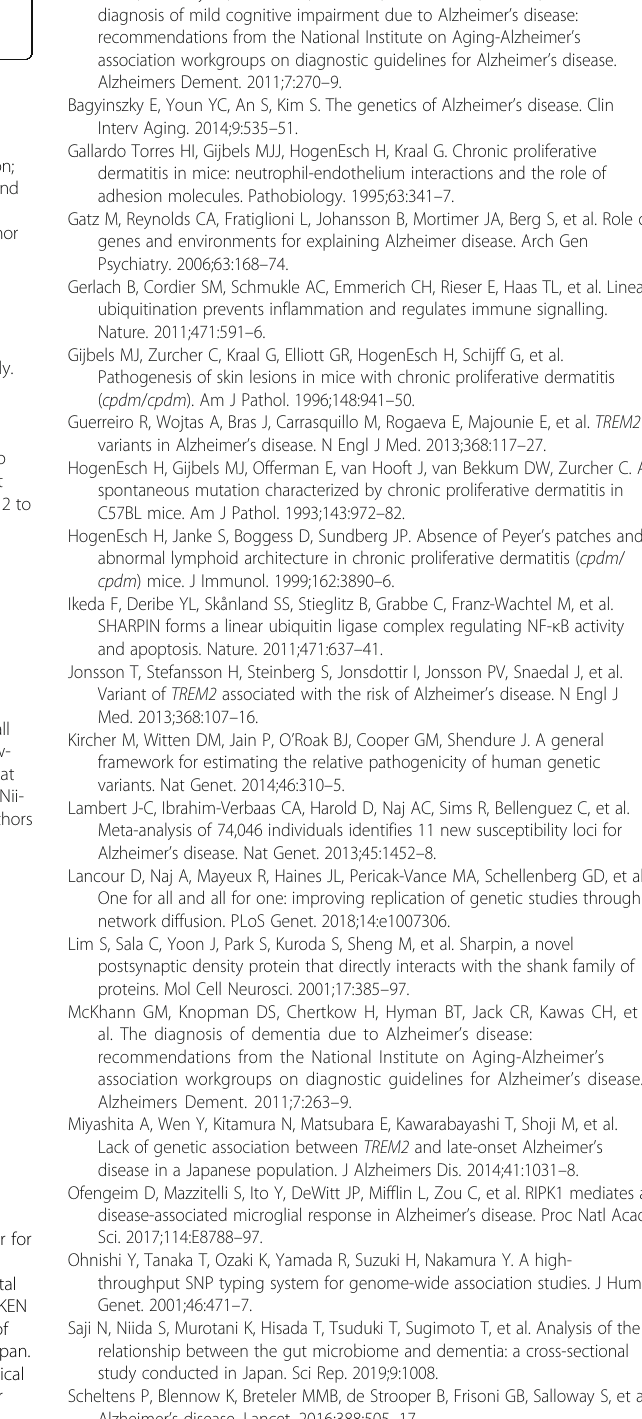
species. Protein sequences of SHARPIN for each species were obtained from UniProt and the region near G186 was compared. Table S1. Samples used for exome sequencing. Table S2. Demographic features of the NCGG samples genotyped. Table S3. Samples used in the first association study of candidate AD risk variants. Table S4. Demographic features of the second cohort set used in the association study. Table S5. Ten genes with significantly accumulated variants. Table S6. Accumulation of variants in LOAD patients compared with NC controls. (PDF 3193